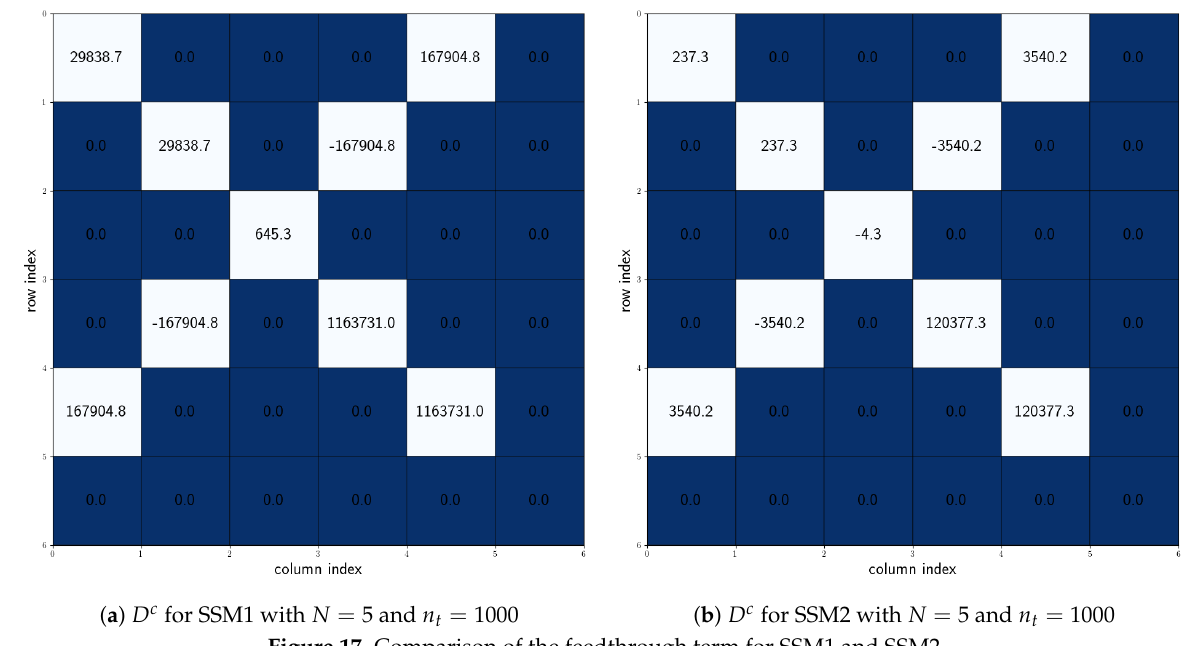
Figure 17. Comparison of the feedthrough term for SSM1 and